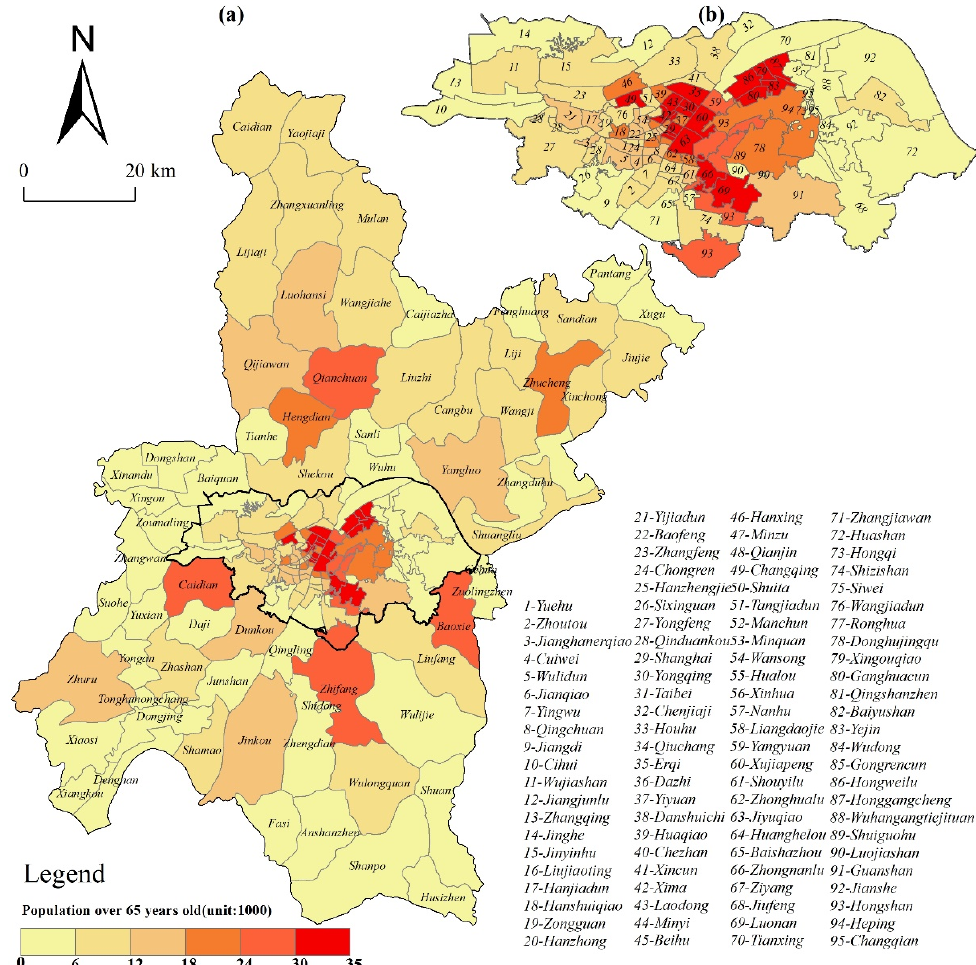
Figure 3. Spatial pattern of the street-level aging population in Wuhan of China, for 2020. The street name label is available in the figure. ( a ) The whole study area, and ( b ) enlargement of the black frame area in ( a ).